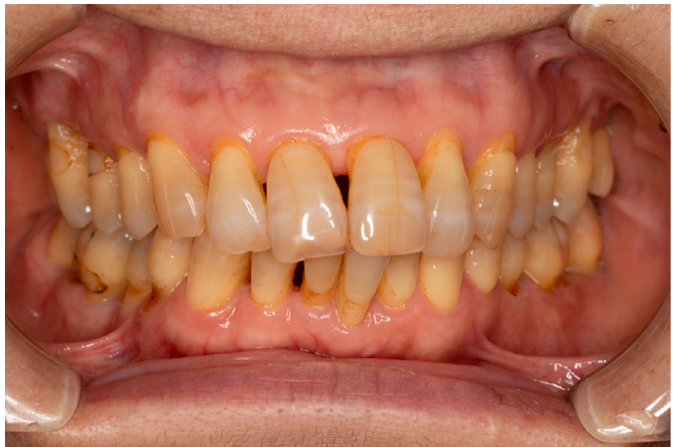
Figure 1. Typical clinical appearance after conventional periodontal treatment. Black triangles appear because of the gingival recessions, resulting in both functional and aesthetic problems. Gingival recessions occurred in all dentitions, resulting in hypersensitivity and root caries.